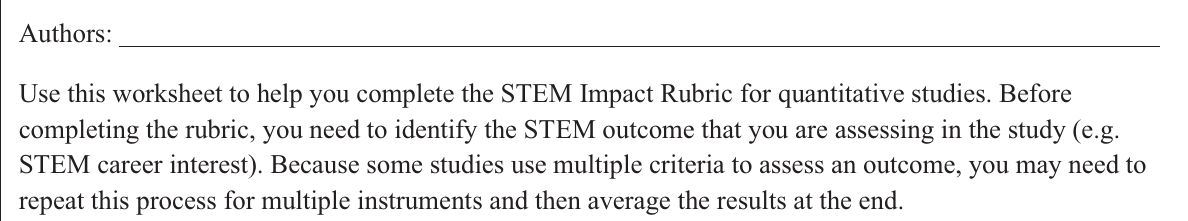
FIGURE 2 | STEM Impact Rubric worksheet for quantitative